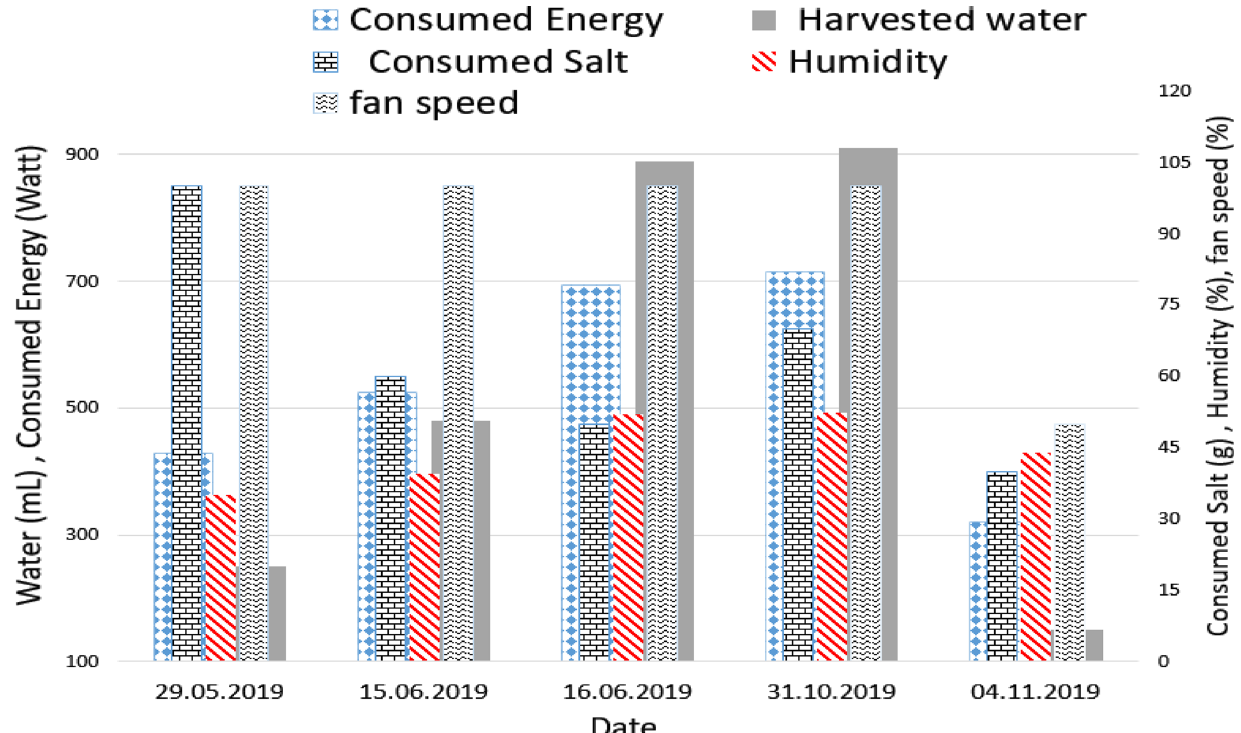
Fig. 11 Variation in the amount of water produced, the amount of salt and energy consumed for the